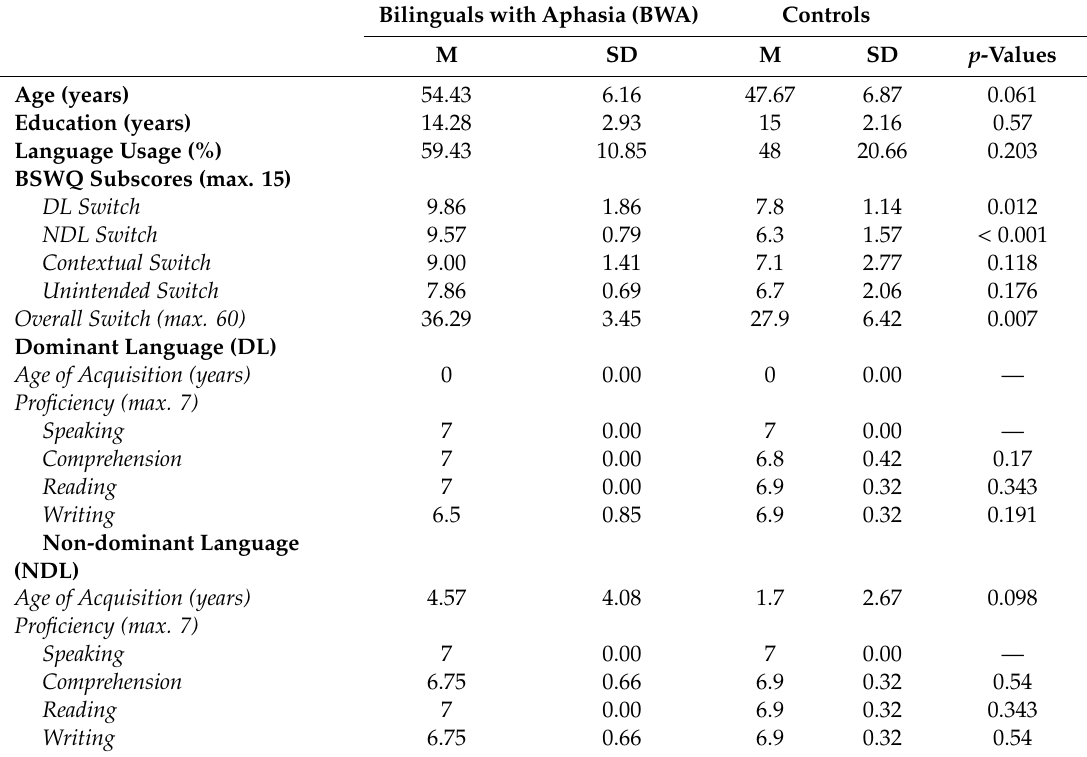
Table 2. Sociodemographic and linguistic measures for Bilinguals with Aphasia (BWAs) and controls. Bilinguals with Aphasia (BWA)